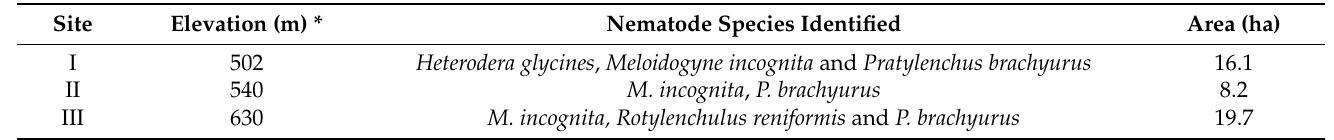
Figure 1. Characterization of the experimental area. (I) Guaíra and Jaboticabal cities highlighted with different colors/symbols within the state of São Paulo and Brazil maps. (II), (III) and (IV) site experiments with white circles representing the georeferenced sampling points. Table 1. Elevation, nematode species identified, and total area (ha) for each